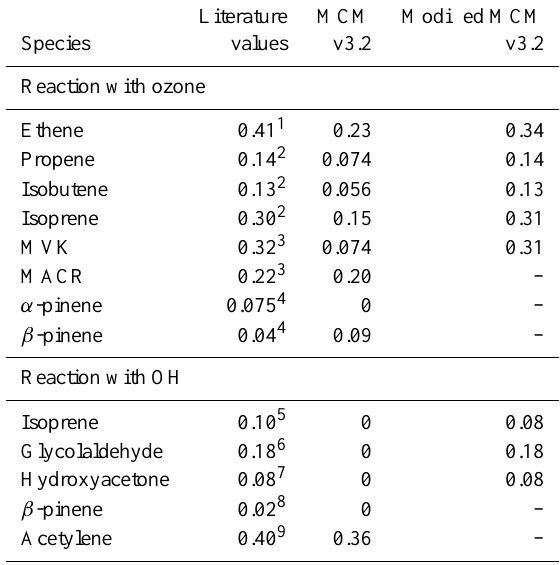
Table 2. Yields of formic acid from reactions of alkenes and other unsaturated compounds with ozone and OH